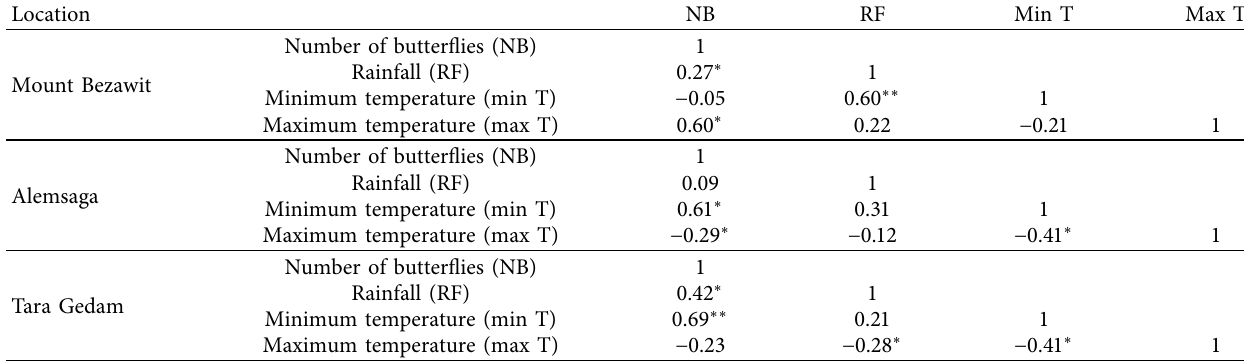
Table 6: Correlation analysis between butterfly abundance and weather variables at three locations.